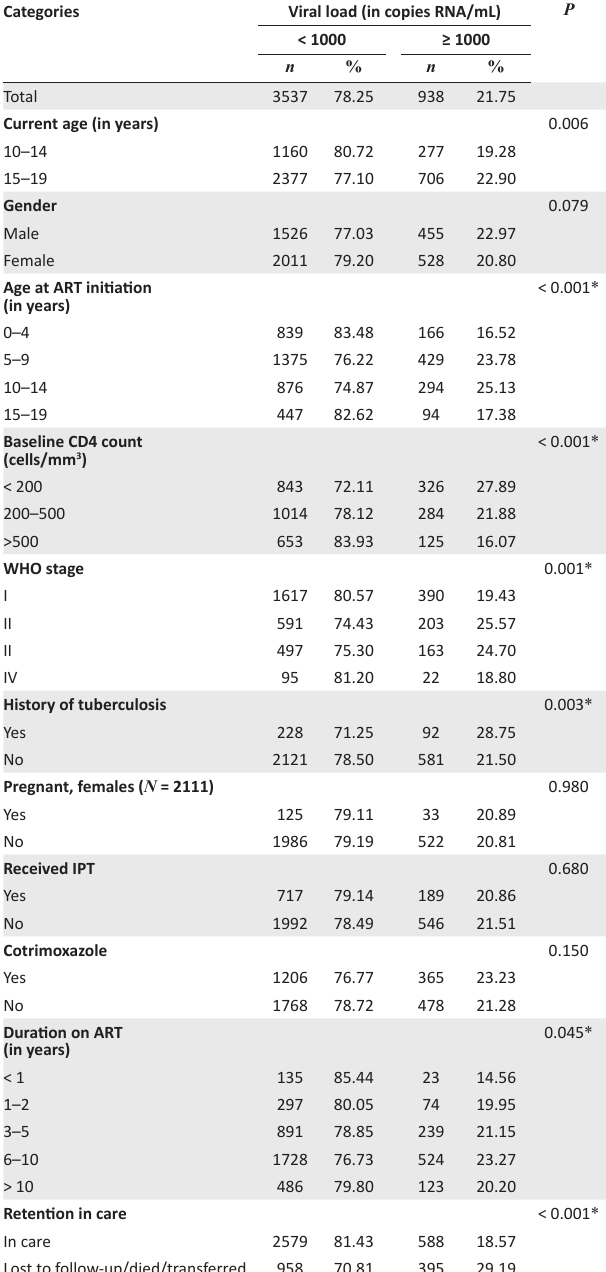
TABLE 1: Viral load by demographic and clinical characteristics of adolescents on ART in the Thabo Mofutsanyane District, Free State province, 2019. Categories